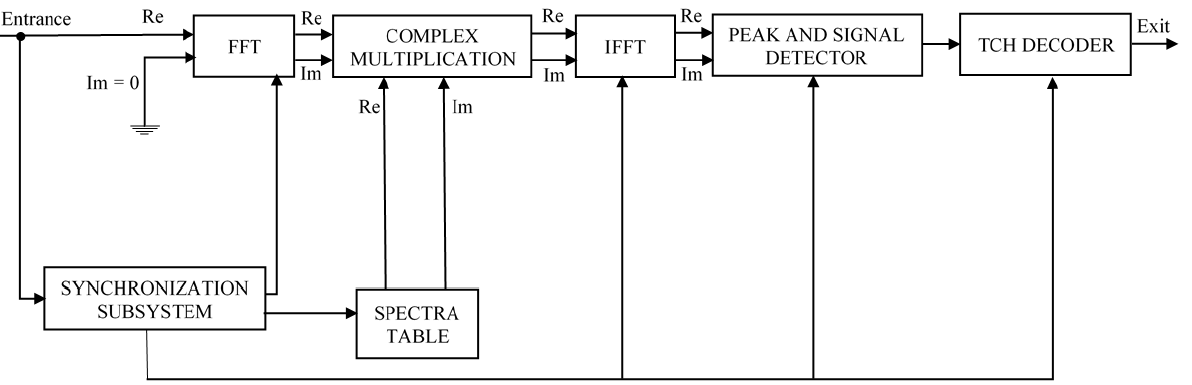
Figure 4. TCH decoder